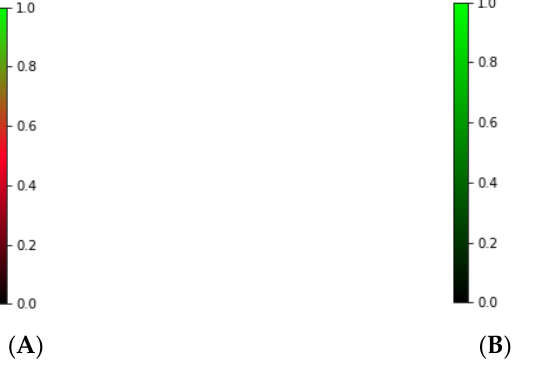
Figure 2. Proposed color map of the remaining health: ( A ) from the beginning of life until the expected SOH reaches the EOL + 3%; ( B ) from when the expected SOH is EOL +3% to the